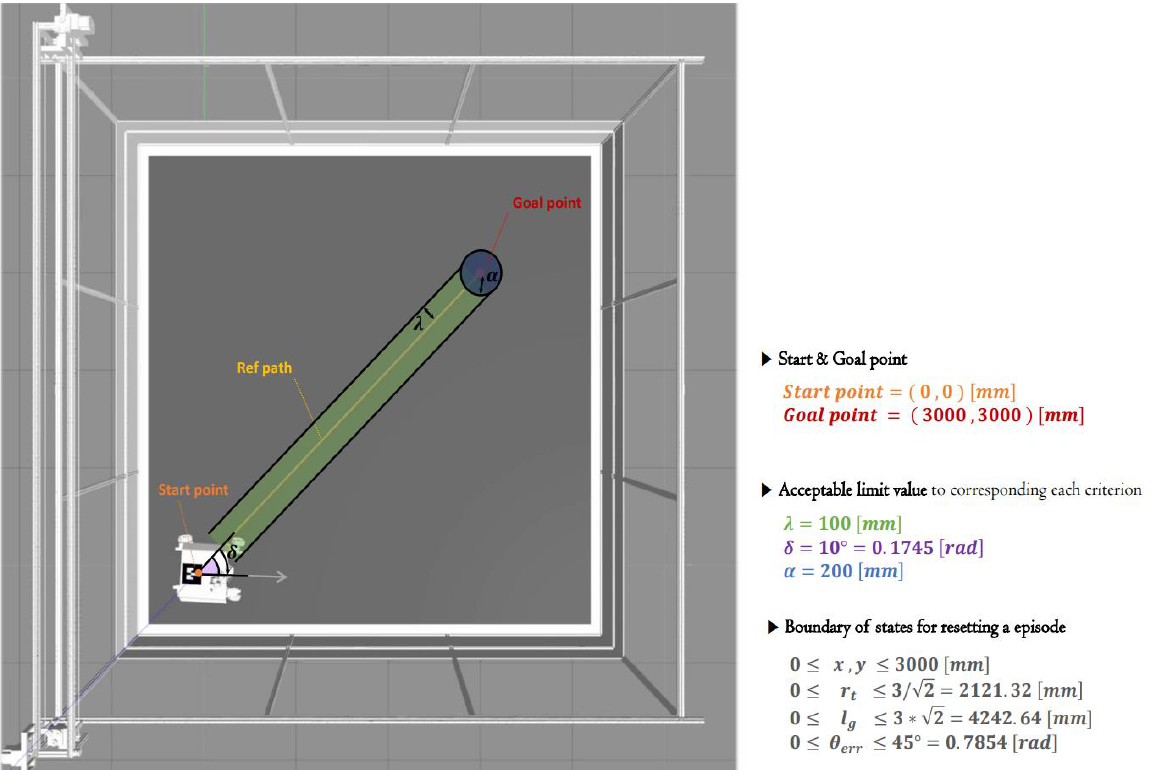
Figure 18. Experimental parameter setting for training and test episodes.